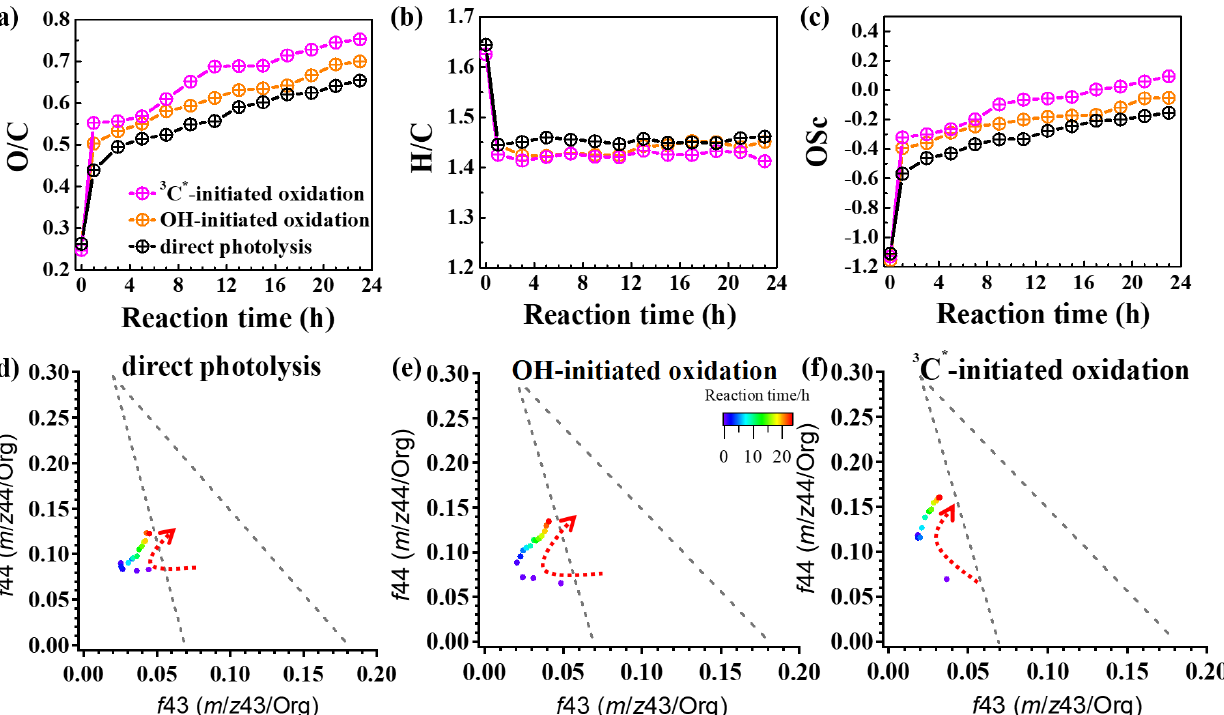
Figure 9. Variations in the elemental ratios of (a) O / C, (b) H / C, and (c) oxidation state (OSc) as a function of reaction time. The f 44 vs. f 43 plots of reaction products under (d) direct photolysis, (e) OH-initiated oxidation, and (f) 3 C ∗ -initiated